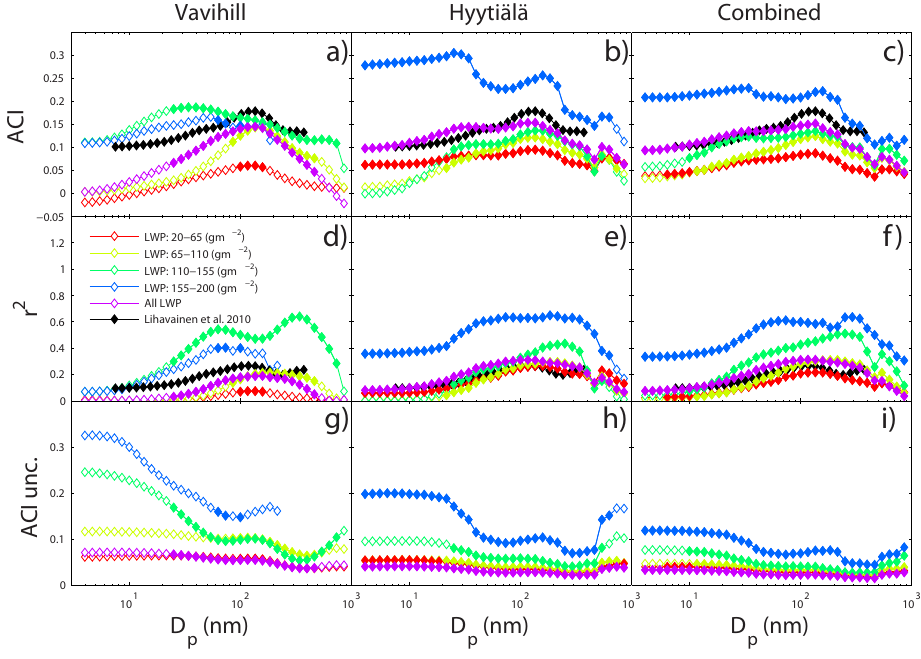
Figure 6. Aerosol–cloud interaction (ACI) versus D p , which is the lower limit for the aerosol number concentration used to calculate the ACI, for (a) Vavihill, (b) Hyytiälä and (c) the combined data set. Squared correlation coefficients ( r 2 ) between the aerosol and cloud parameter as a function of D p are shown in (d) for Vavihill, (e) for Hyytiälä and (f) for the combined data sets. Uncertainty in the calculated ACI as a function of D p are displayed in (g) for Vavihill, (h) for Hyytiälä and (i) for the combined data sets. The ACI is calculated from the r e at 3.7µm and N 130 . The ACI has been calculated for 4 subsets of the data according to LWP and for all LWP values together. The solid markers denote statistically significant correlations with a 95% confidence interval. Also included in the figure are results obtained by Lihavainen et al. (2010), who did not divide the data according to liquid water path (LWP).